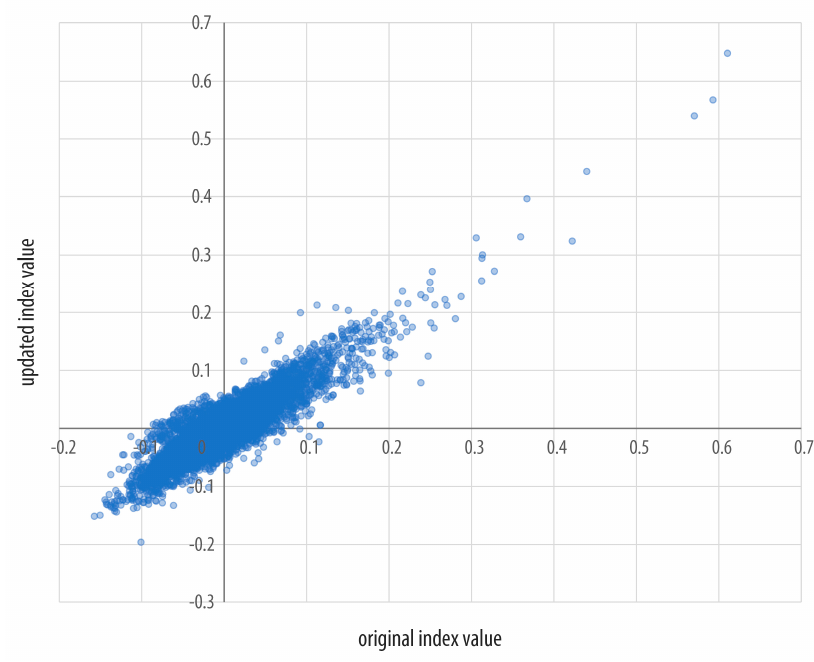
Figure 3. Non-spatial comparison of the original and adjusted index.